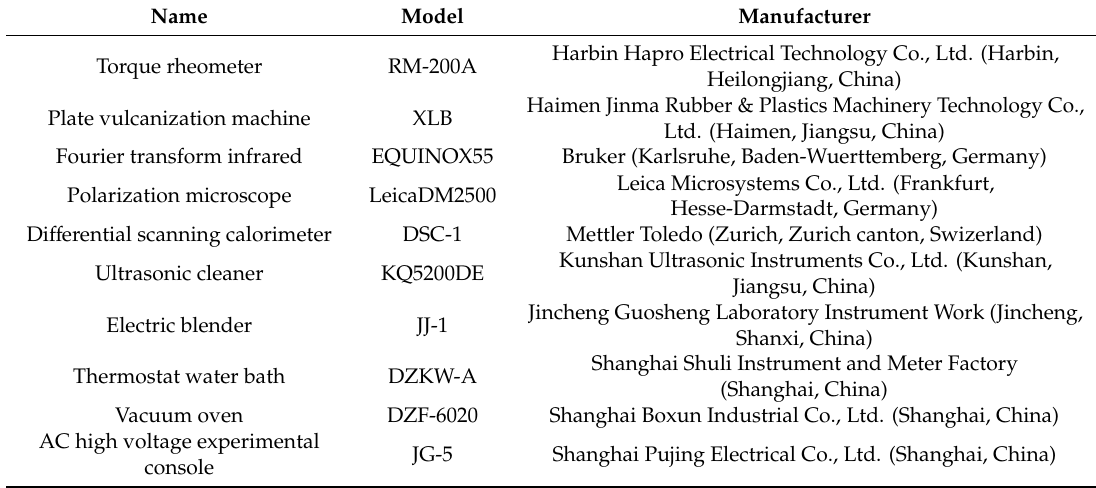
Table 1. The name and filler content of the tested